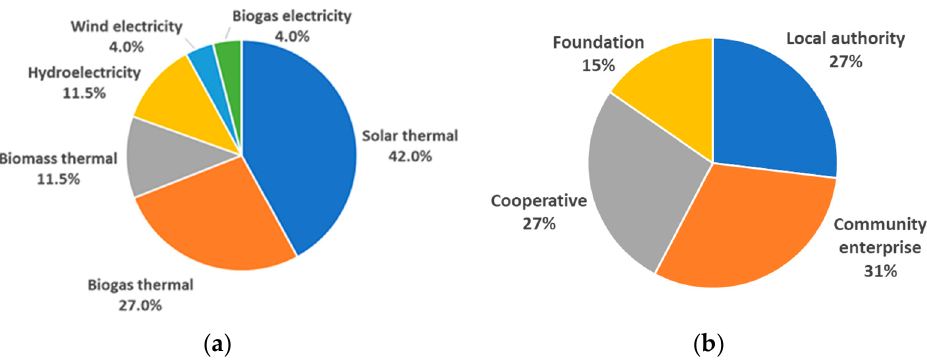
Figure 2. Detail of community energy projects: ( a ) Energy generation activities and ( b ) group types of the 26 CRE projects.